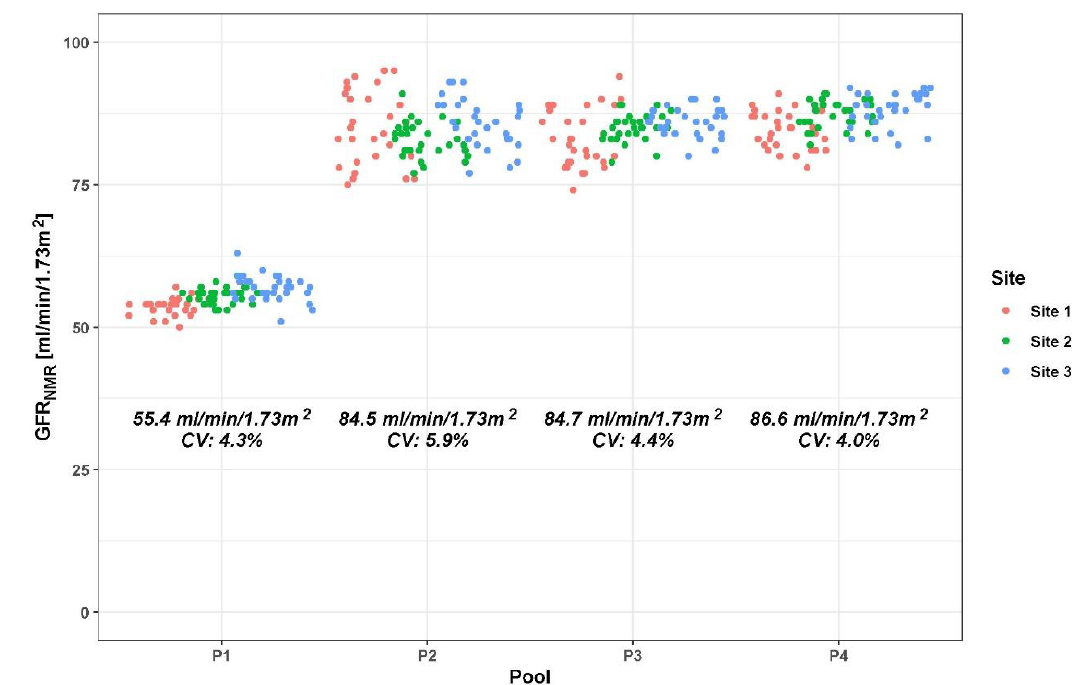
Figure 2. Scatterplot of multi-site precision (reproducibility) for the GFR NMR equation calculated from 4 serum pools (P1–P4) with mean GFR NMR scores below and above 60 mL/min/1.73 m 2 . Abbreviation: CV%, coefficient of variation.